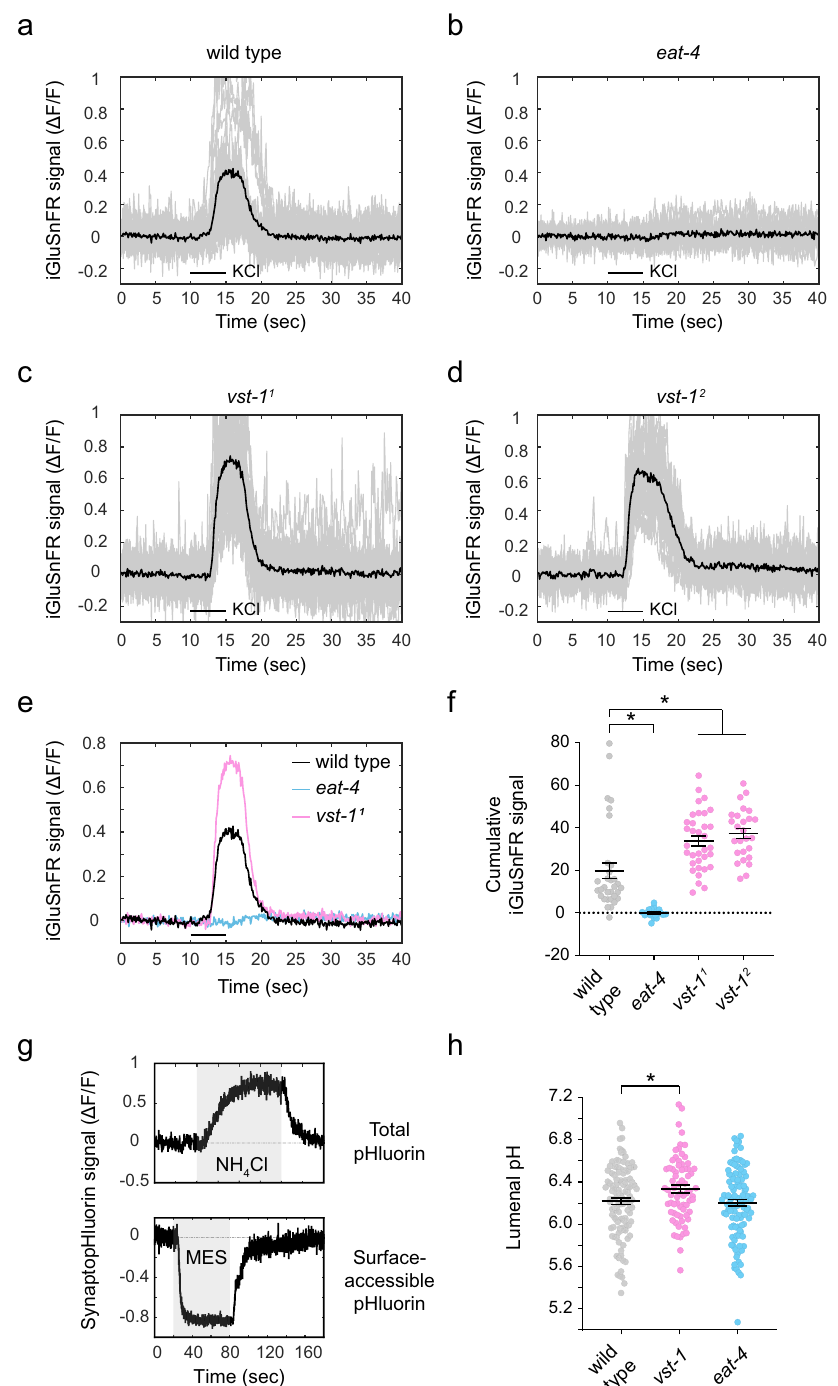
were signi fi cantly lower than those of the wild type (Fig. 5a, d). Also, after repeated stimulation, the evoked turning response of vst-1 mutants was signi fi cantly greater than that of the wild type, suggesting that these mutants became partially sensitized to CO 2 stimuli in a manner that the wild type did not (Fig. 5a, d). These data show that VST-1 is required for normal foraging behavior and for acute behavioral responses to CO 2 stimuli. Importantly, many effects of vst-1 mutation depended upon synaptic glutamate signaling. eat-4/VGLUT mutants displayed abnormal slowing responses to CO 2 stimuli and their turning responses to repeated CO 2 stimuli also differed from those of the